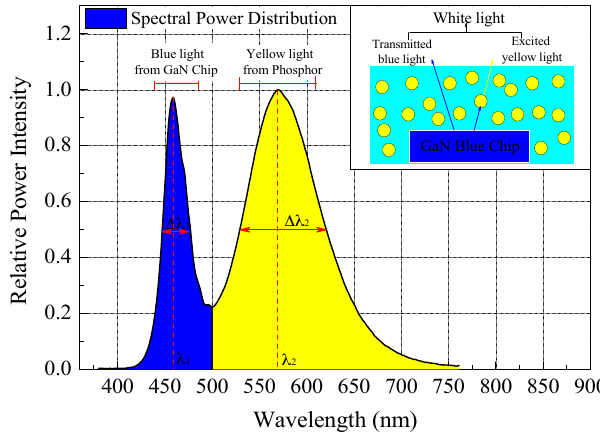
Figure 3. SPD and luminous mechanism of the selected phosphor-converted white LED (pc-WLED) package.